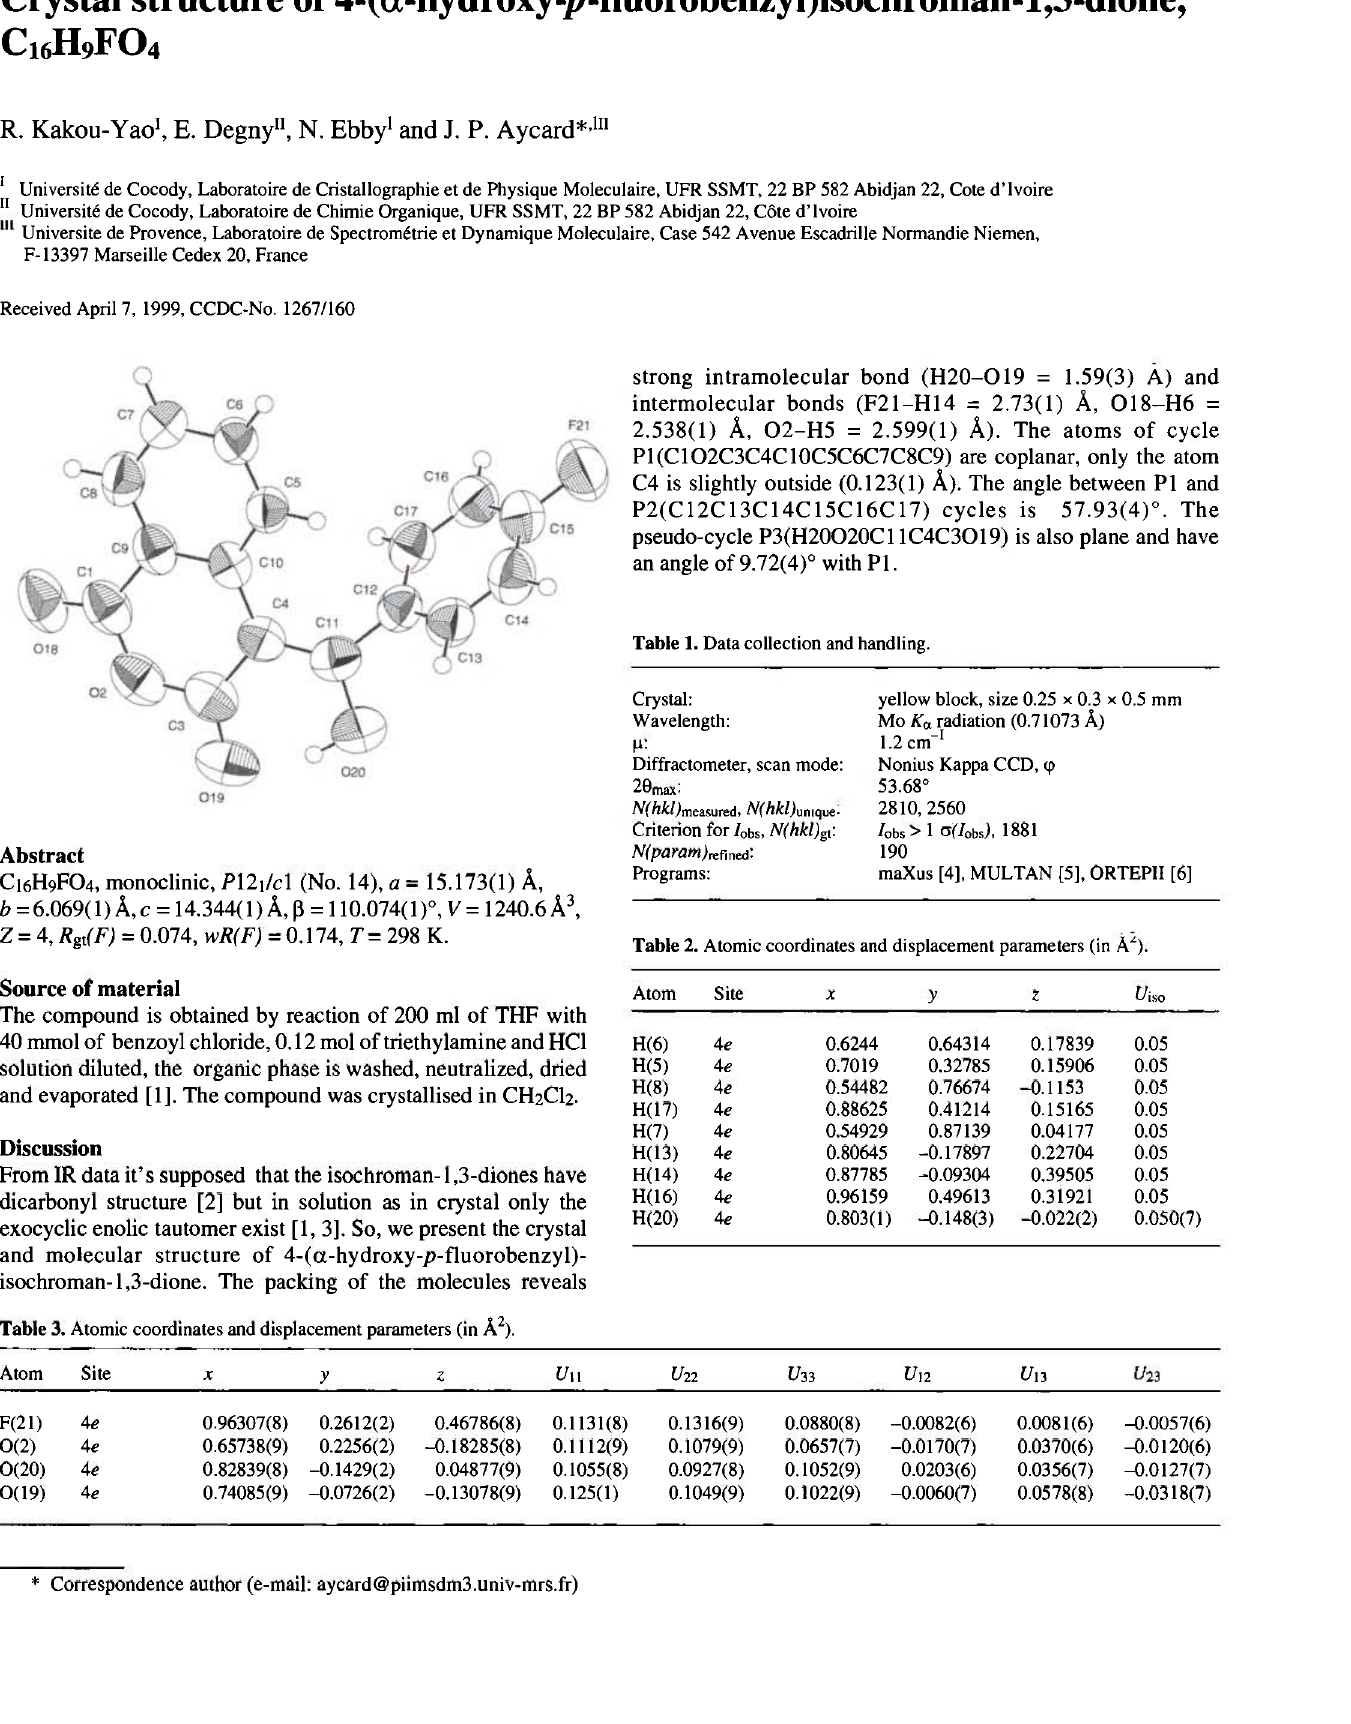
Table 3. Atomic coordinates and displacement parameters (in A 2 ).